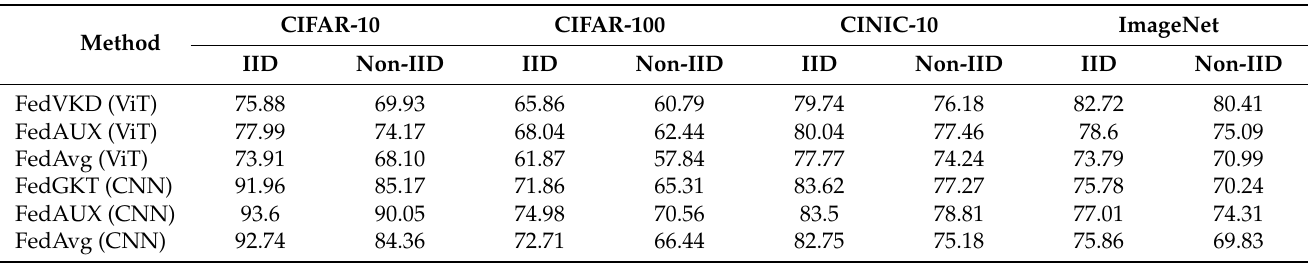
Table 1. Comparison of the test accuracy of our method and several state-of-the-art methods over four datasets in IID and non-IID